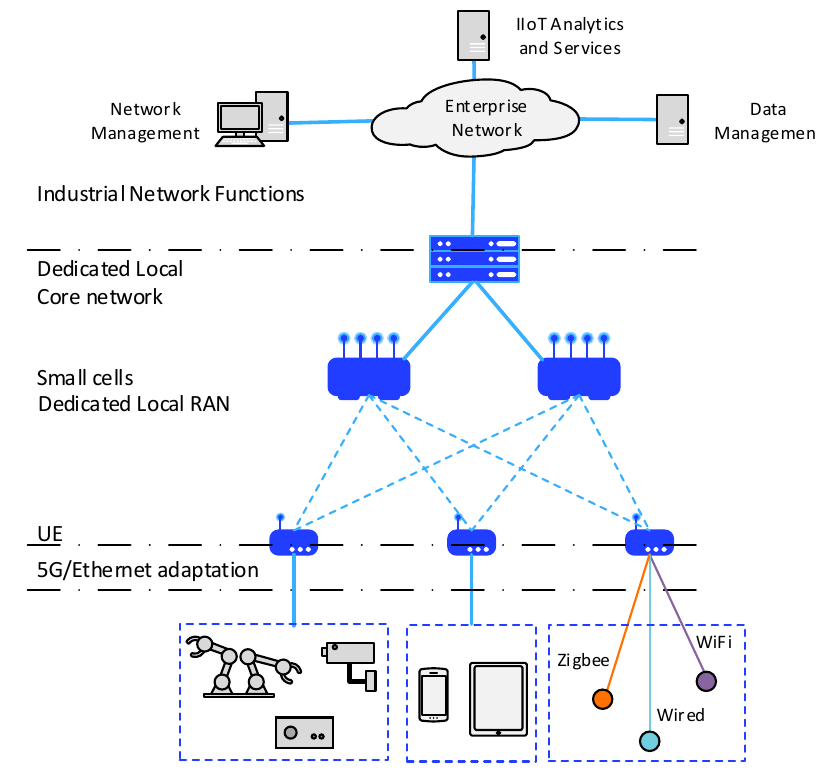
Figure 3. Factory of the future using a dedicated local type-b network for industrial automation.